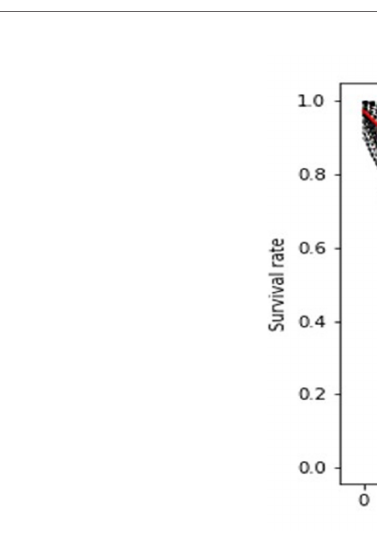
FIGURE 4 | Predicted Survival Curve (DeepHit).